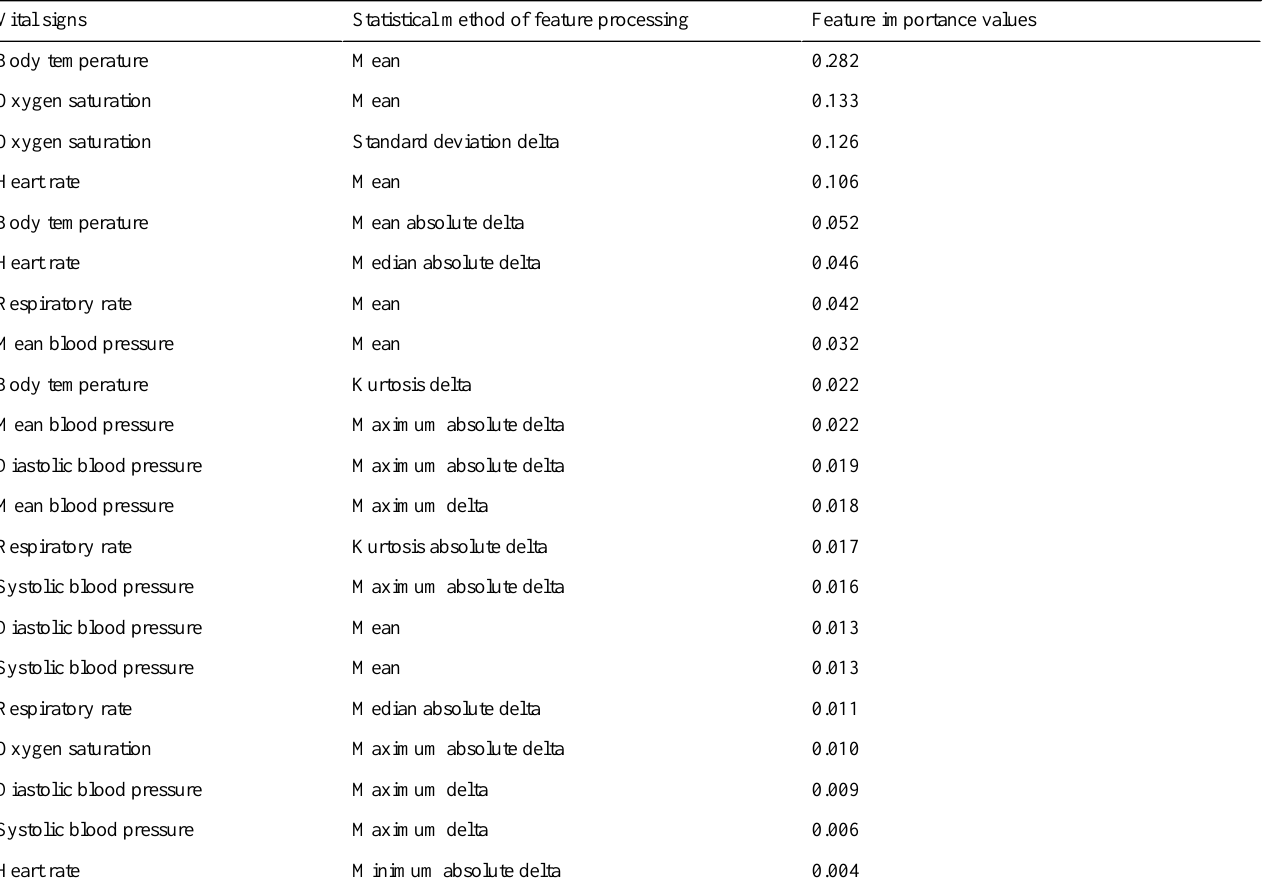
Table 5. An example of the prediction feature importance obtained from the prediction model based on the feature selection algorithm.